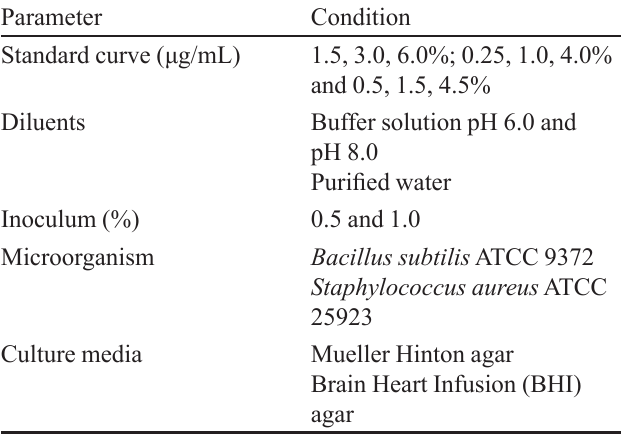
TABLE I - Tested conditions to establish the parameters for microbiological assay of CHX digluconate